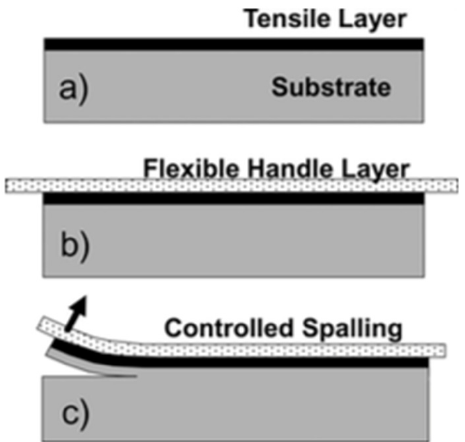
Figure 4. Schematic representation describes the main steps ( a – c ) of spalling [12,13]. Silicon (Si(100)) spalling at 77 K (liquid nitrogen temperature) is described schemati- cally in Figure 4. Moreover, Figure 5 shows successful spalling of Si(111) wafer from the ingot.